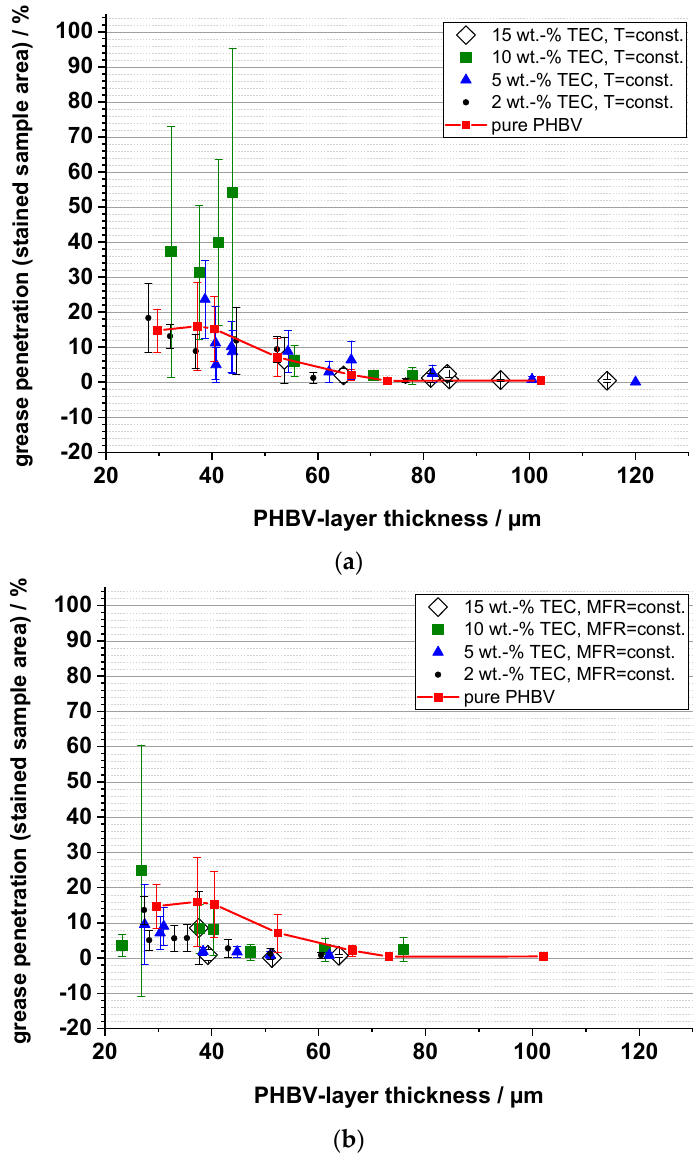
Figure 14. Grease barrier (staining) of paper coated with PHBV layers blended with triethyl citrate (TEC): ( a ) temperature (T) during extrusion constant; ( b ) melt flow rate (MFR) during extrusion constant. Thickness: PHBV thickness.